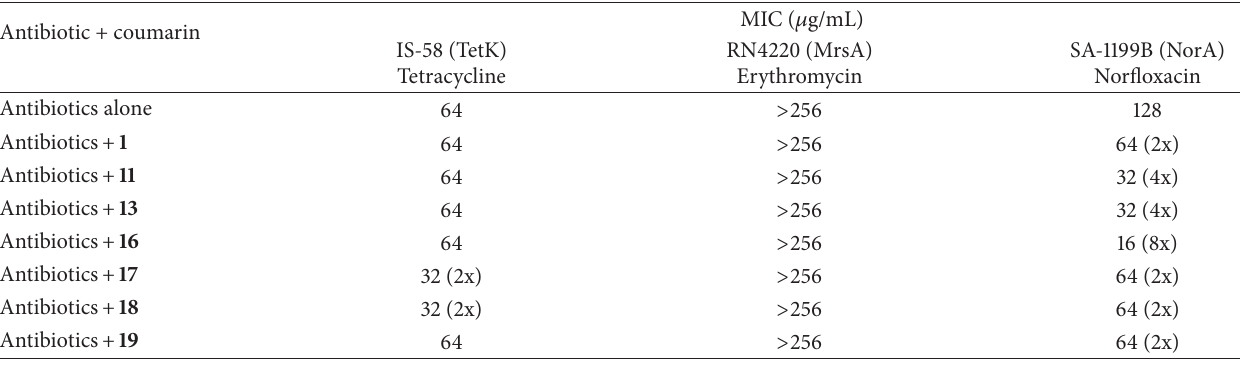
Table 1: MIC values ( 𝜇 g/mL) of antibiotics in the absence and presence of coumarin derivatives against S. aureus strains: SA-1199B (NorA), RN4220 (MsrA), and IS-58 (TetK).